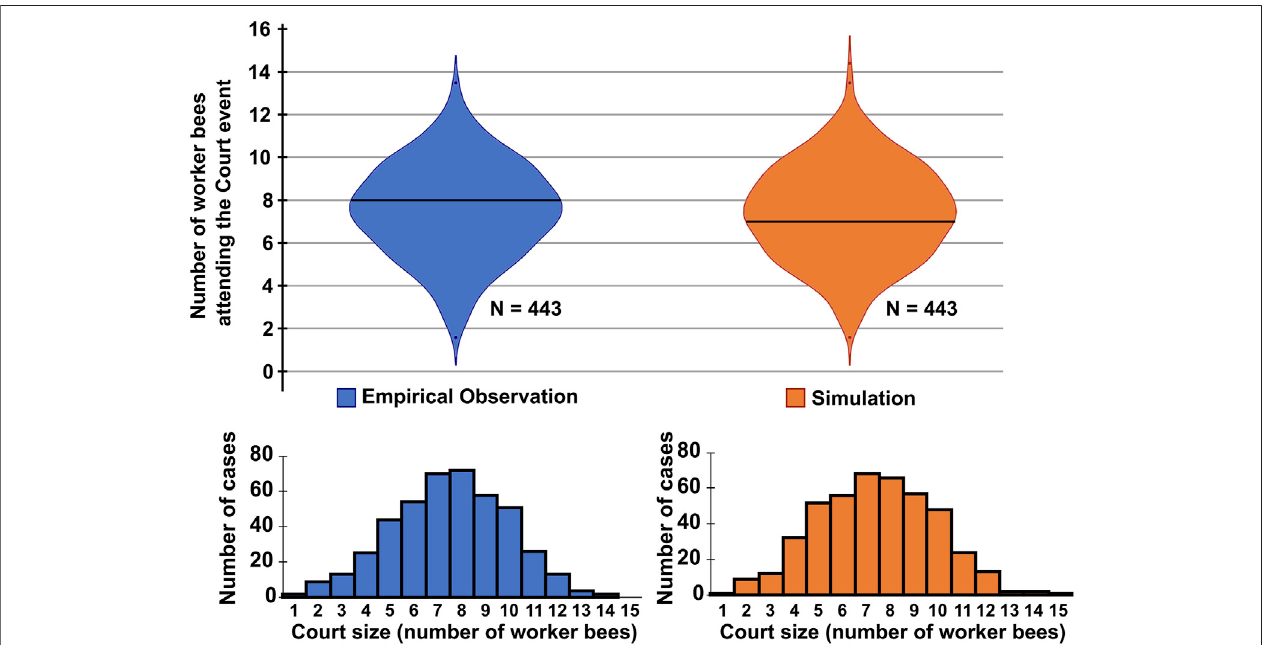
FIGURE 6 | Violin plots and histograms for comparing emerging court sizes of empirical observation (left, blue) and model simulation (right, orange). For empirical data, 443 queen resting events of 180 h of video recording were manually detected and the size of the court was determined at the middle of the event. For the model